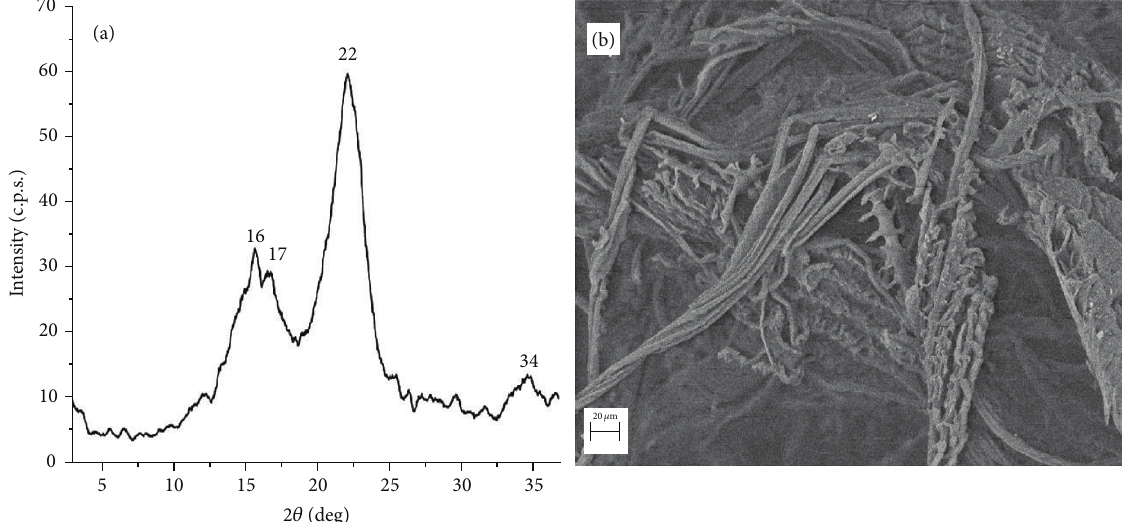
Figure 18: (a) XRD patterns and (b) SEM micrograph of the extracted cellulose